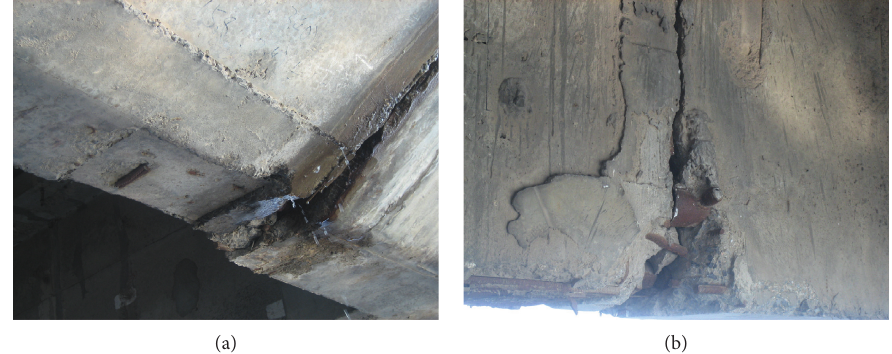
Figure 4: In-site photographs of damage in the closure segment: (a) severe opening at the bottom of the wet joint; (b) fracture of steel bars inside the vertical web of the joint section.